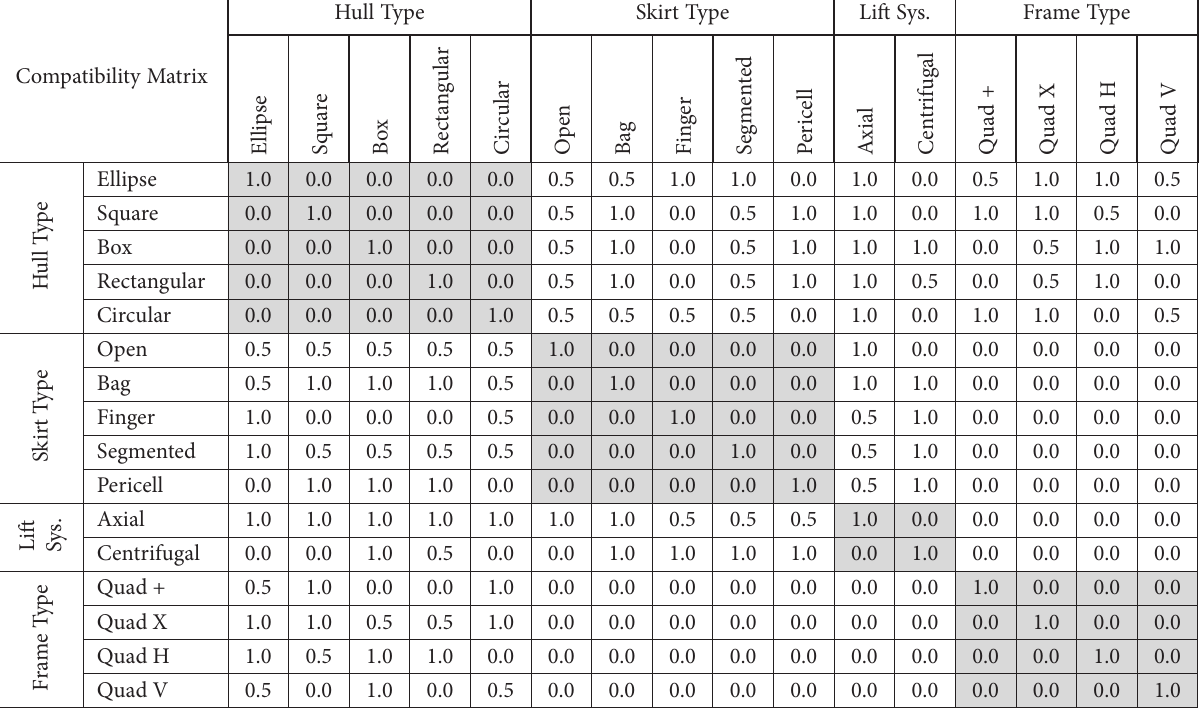
Table A1. Compatibility matrix of design variables